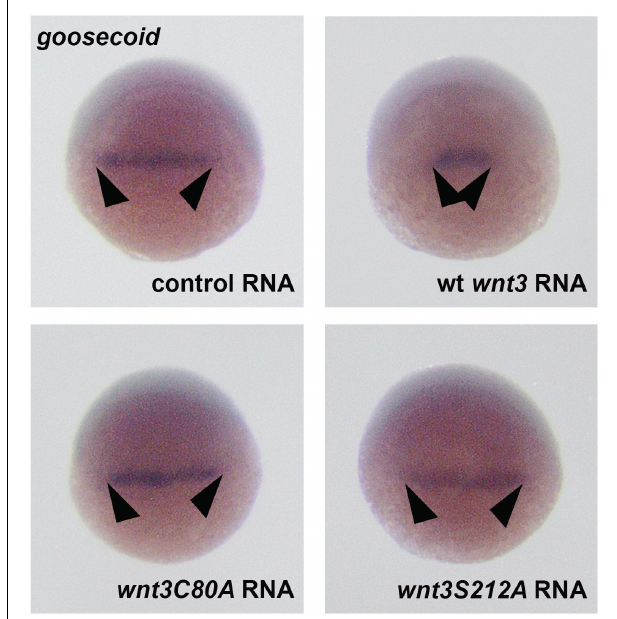
FIGURE 10 | Whole mount in situ hybridization for the dorsal organizer marker gene goosecoid ( gsc ) in wt embryos at the shield stage, showing the effects of control (EGFP 100 pg, 35/35 embryos, arrowheads: normal gsc expression domain), Wnt3-EGFP (100 pg, 31/35 embryos, arrowheads: reduction in gsc expression domain), Wnt3C80A EGFP (100 pg, 38/41 embryos, arrowheads: no effect on gsc expression domain), and Wnt3S212A-EGFP (100 pg, 32/34 embryos, arrowheads: no effect on gsc expression